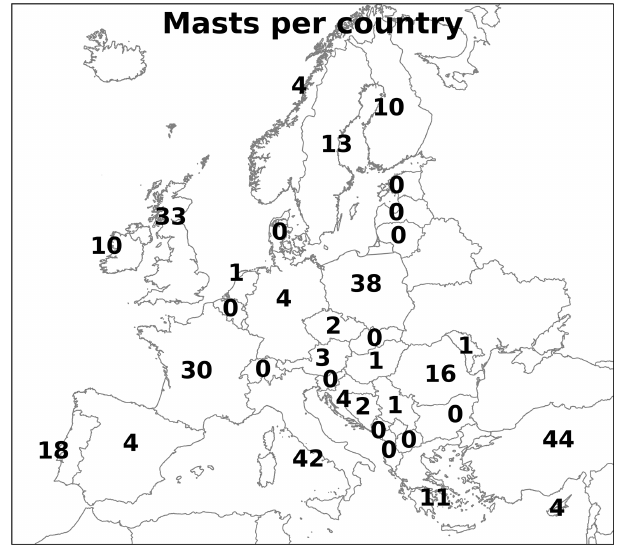
Figure 4. The number of masts located in each country in Europe. For several smaller countries the number has been omitted for read- ability (all of them have zero